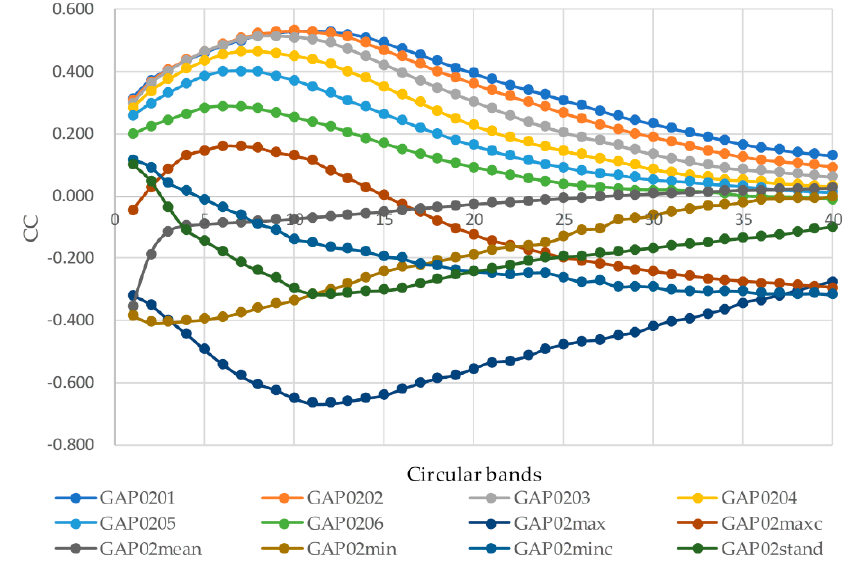
Figure 5. Correlation coe ffi cients (CCs) between 480 predictors and tropical cyclone (TC) intensity.